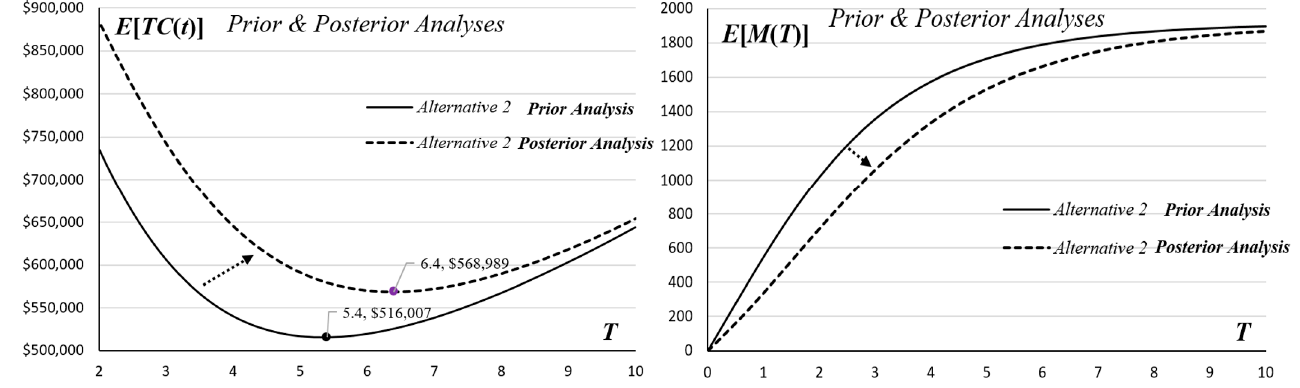
Figure 9. The comparisons between the prior and posterior analyses. on the expected total testing cost and number of errors detected.